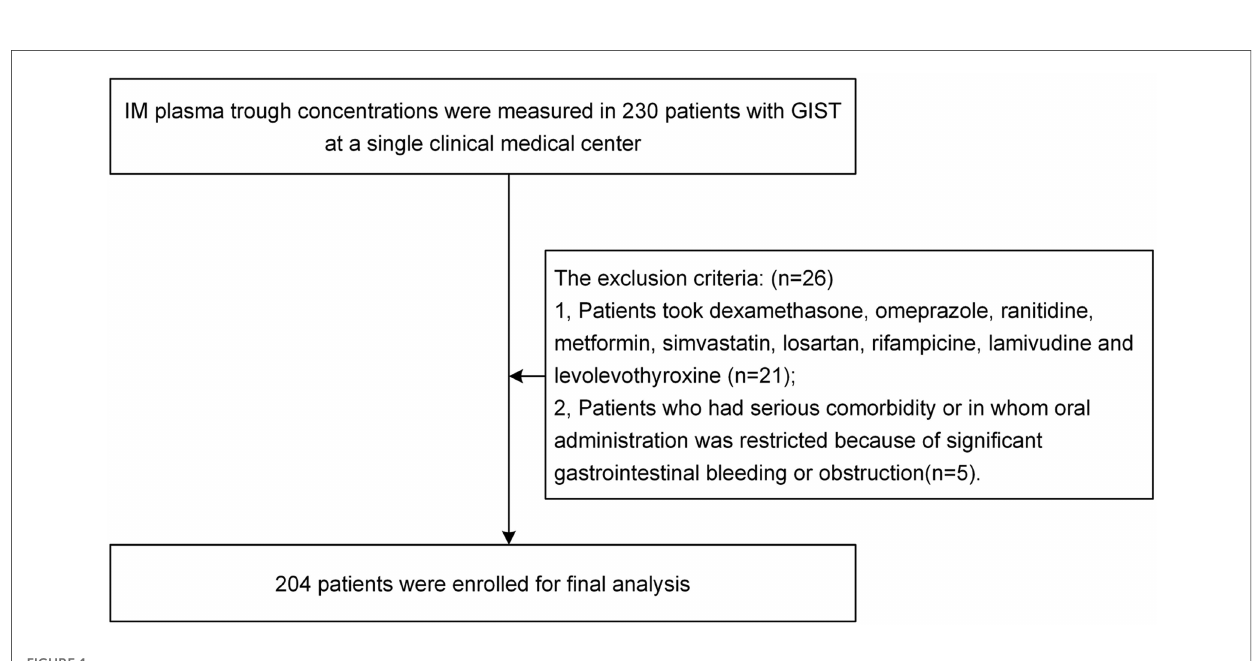
FIGURE 1 Flow chart of patient selection.